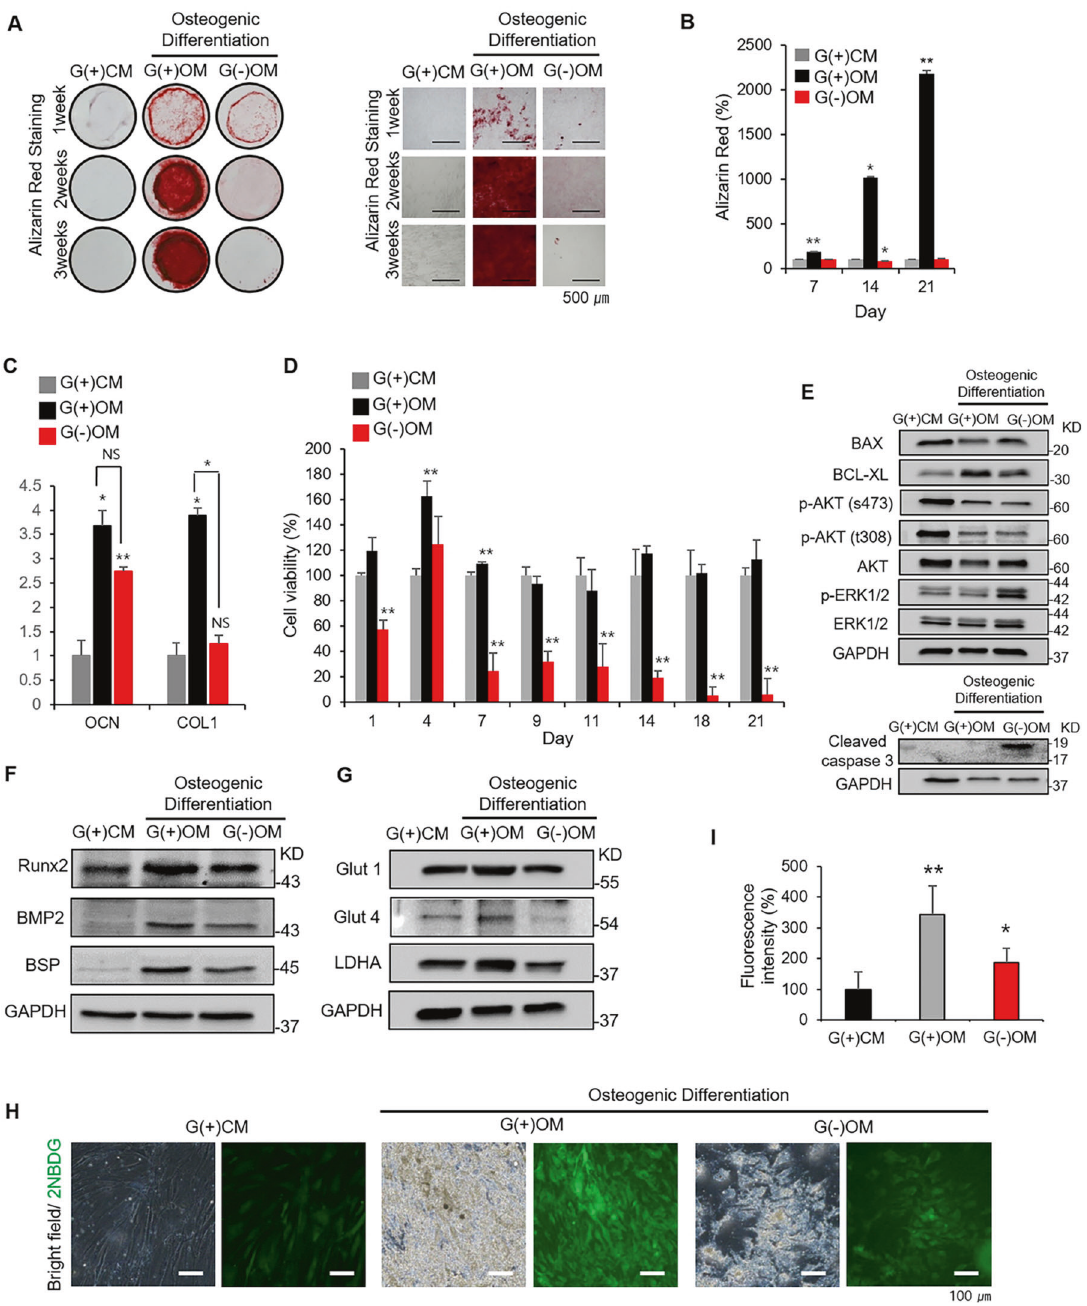
Fig. 1 The effects of glucose on osteogenic differentiation and survival of hBMSCs. A Images show Alizarin Red staining of hBMSCs under various conditions, enlarged images (×100) and B quanti fi cation at 7, 14, and 21 days of culture. C Relative gene expression of osteogenic marker type I collagen (COL1) and osteocalcin (OCN) was determined by RT- on day 7 of culture. D Cell viability of G( + )CM, G( + )OM, and G( − ) OM groups after 7, 14, and 21 days of culture. E Western blot of survival markers (BAX, BCL-XL, p-AKT, AKT, p-ERK, ERK, and Cleaved caspase 3) on day 7 of culture. F Western blot of osteogenic markers (Runx2, BMP2, and BSP), and G markers of glucose metabolism (Glut1, glut4, and LDHA) of hBMSCs in G( + )CM, G( + )OM, and G( − )OM groups on day 7 of culture. H Bright- fi eld and fl uorescent images of hBMSCs with 2NBDG tagged after 14 days of culture. I Quanti fi cation of fl uorescent images for hBMSCs with 2NBDG tagged after 14 days of culture. Data were presented as mean ± standard deviation (SD, N = 3). NS: no signi fi cant difference, * p < 0.05, ** p < 0.01. G( + )CM: undifferentiated hBMSCs cultured under control medium with 5.5 mM glucose; G( + )OM:osteo-induced hBMSCs cultured under osteogenic medium containing 5.5 mM glucose; G( − )OM: osteo-induced hBMSCs cultured under osteogenic medium without were implanted along with fi brin glue into 4 mm-sized segmental defects created in the radii of immunosuppressed rats (Figs. 4A and 5A; schematic diagram of the experiment process). The healing of The in vivo effectiveness of METTL7A-transfected hBMSCs in bone bone defects was assessed radiographically on days 28 and 56, and regeneration was investigated in a rat model of critical-size via on day 56 after implantation (Fig. 5B). Bone regeneration was segmental long-bone defects. 106 METTL7A-transfected hBMSCs